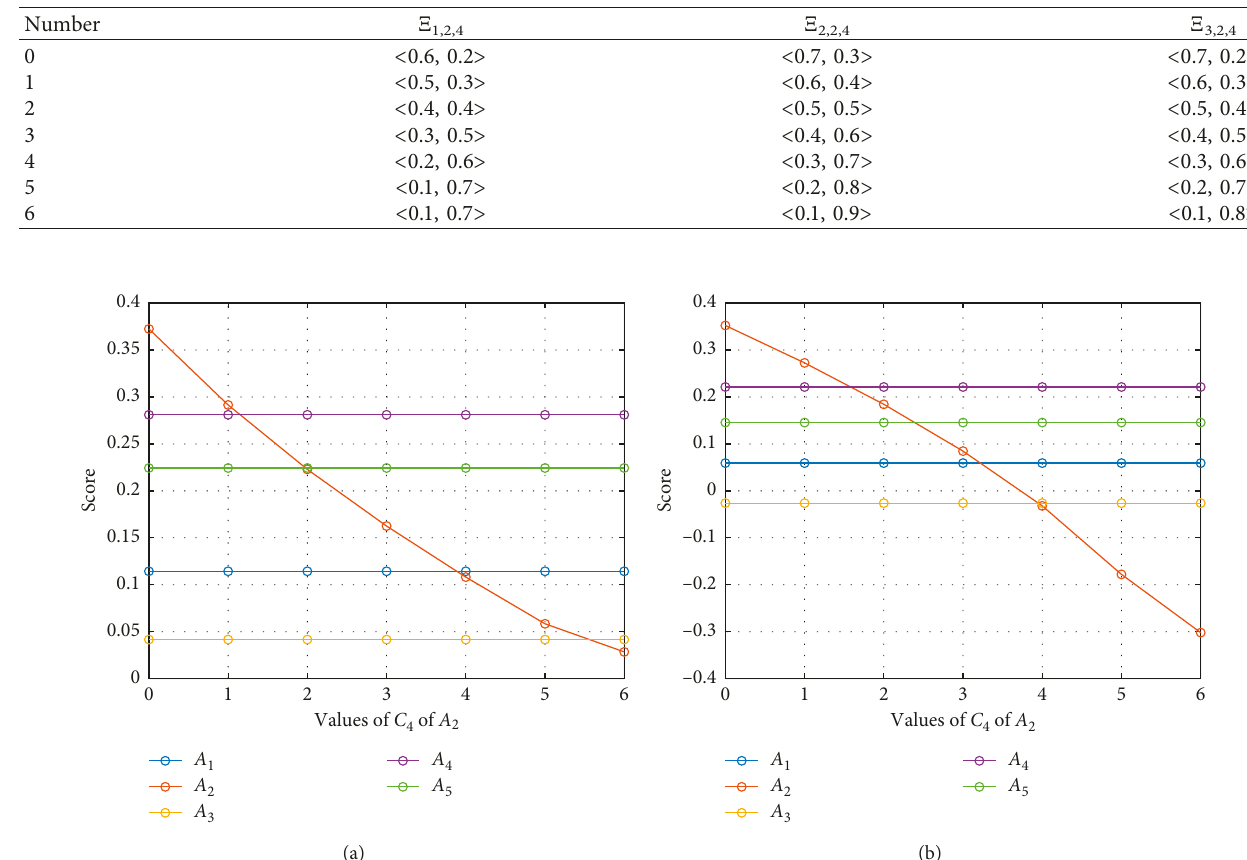
Table 7: Seven groups of Ξ